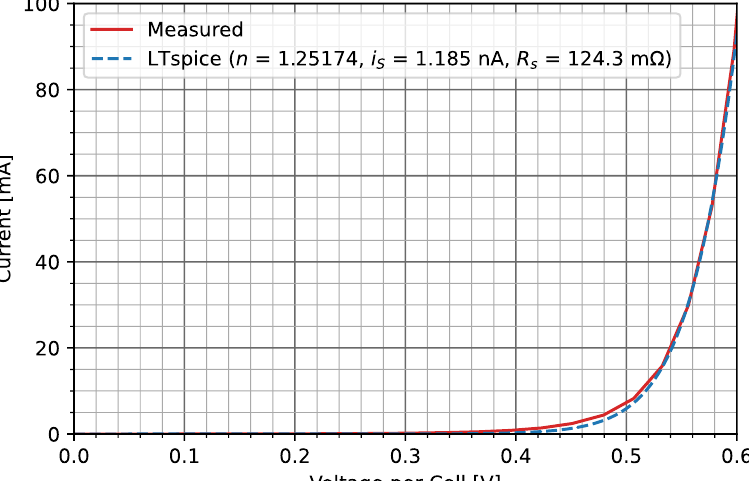
Figure 31. Small PV module measured and simulated current–voltage relationship for positive DC voltages.